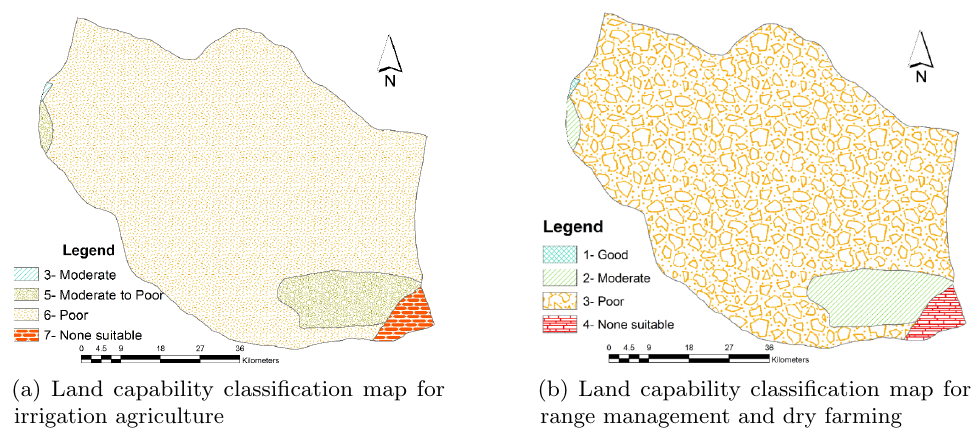
Figure 3: Land capability classification maps